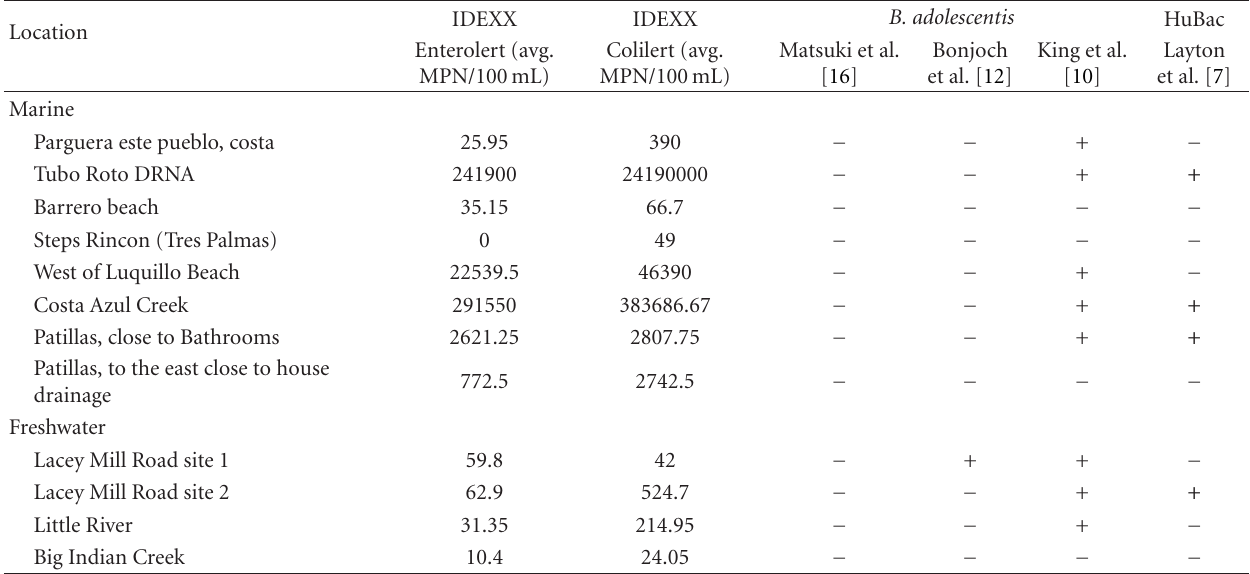
Table 4: PCR-detection of B. adolescentis and HuBac in marine and freshwater